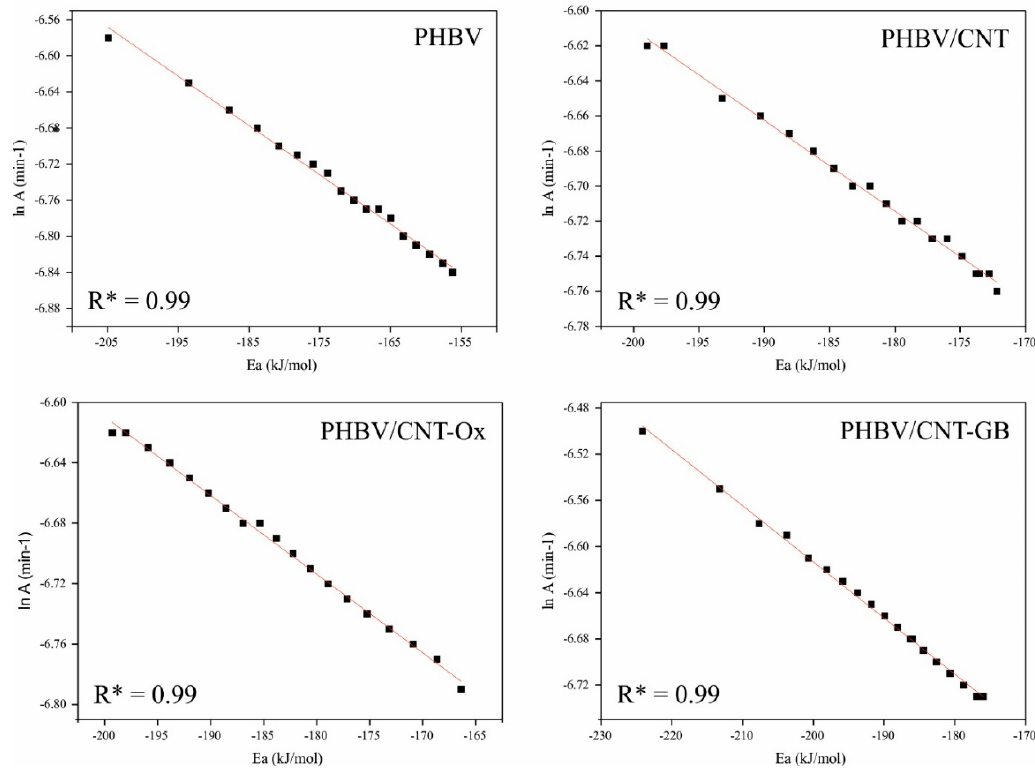
Figure 6. Effect of kinetic compensation for PHBV, PHBV/CNT, PHBV/CNT-Ox and PHBV/CNT-GB. Figure 6. E ff ect of kinetic compensation for PHBV, PHBV / CNT, PHBV / CNT-Ox and PHBV /